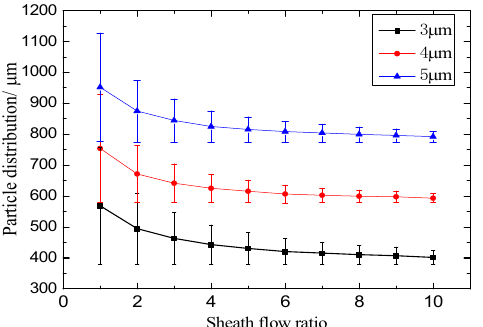
Figure 9. Distribution of various particles at various sheath flow ratios (H = 0.7 × 10 5 A / m, u A + u B = 1.2 mm / s).